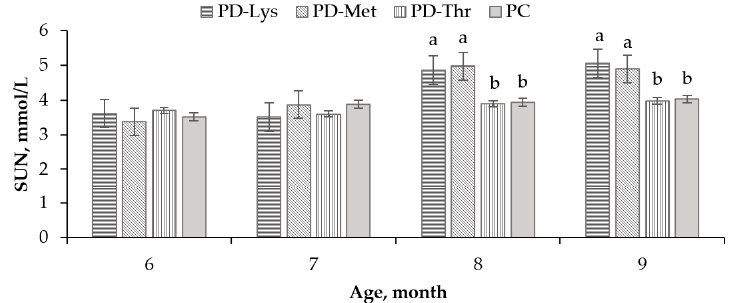
Figure 2. Comparison of serum urea nitrogen levels of seven- to nine-month-old heifers fed corn–soybean based TMRs among the four treatments (n = 24); PD–Lys = 30% Lys deleted TMR diet (diagonal stripes bar), PD–Met = 30% Met deleted TMR diet (vertical stripes bar), PD–Thr = 30% Thr deleted TMR diet (horizonal stripes bar), PC = theoretically balanced amino acid TMR diet (gray bar); The y-axis represents the serum urea nitrogen levels of four treatments; the x-axis was the age of heifers. Error bars indicate SEM. The a,b above the bars indicate the significant di ff erences among treatments ( p <